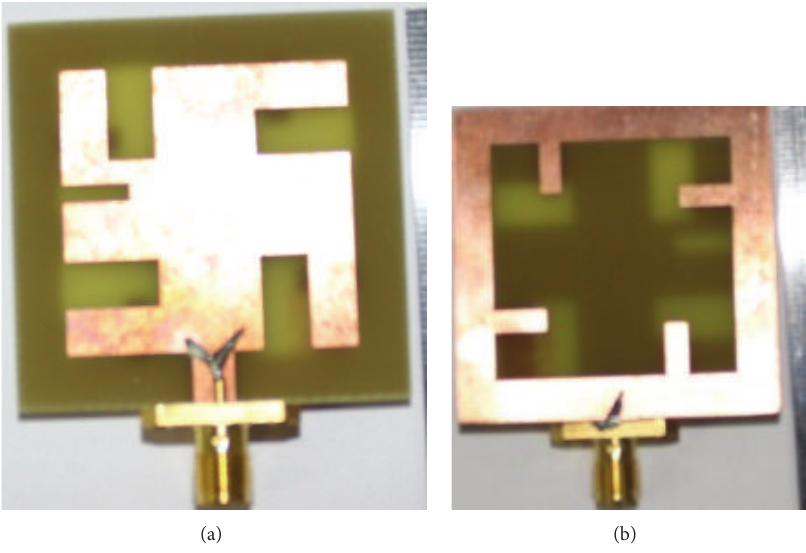
Figure 12: Fabricated prototype. (a) Top view. (b) Bottom